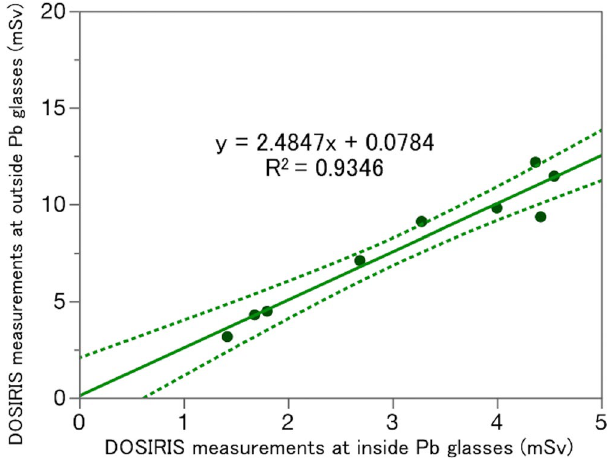
Figure 4. Relationship between the eye dose (DOSIRIS) measurements inside and outside the Pb glasses over 6 months in nine physicians. Dashed line (---): 95% confidence interval.